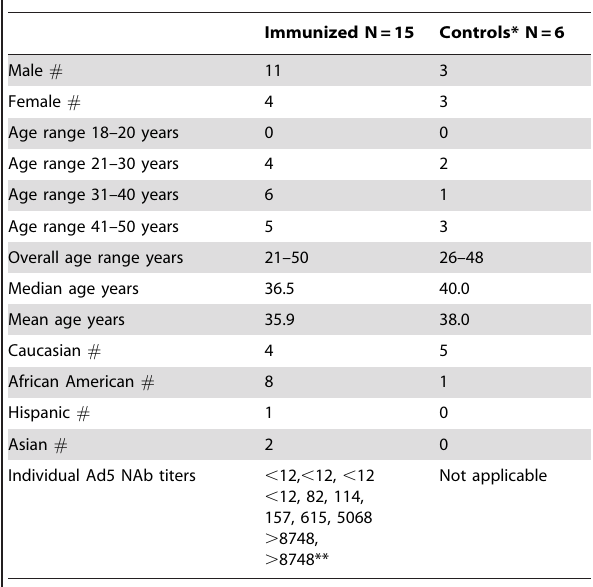
Table 3. Demographics of